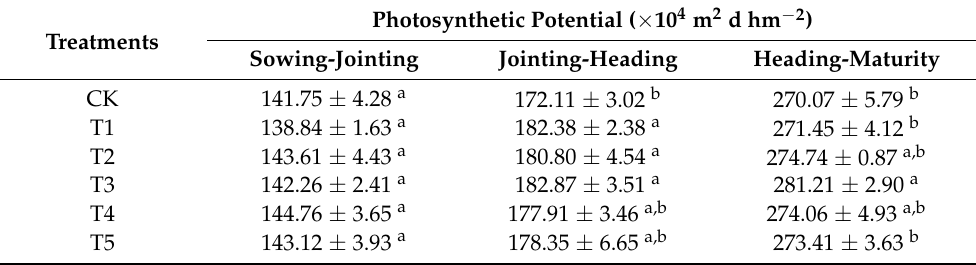
Table 5. Leaf photosynthetic potential of rice under different ZnO NPs application amounts.